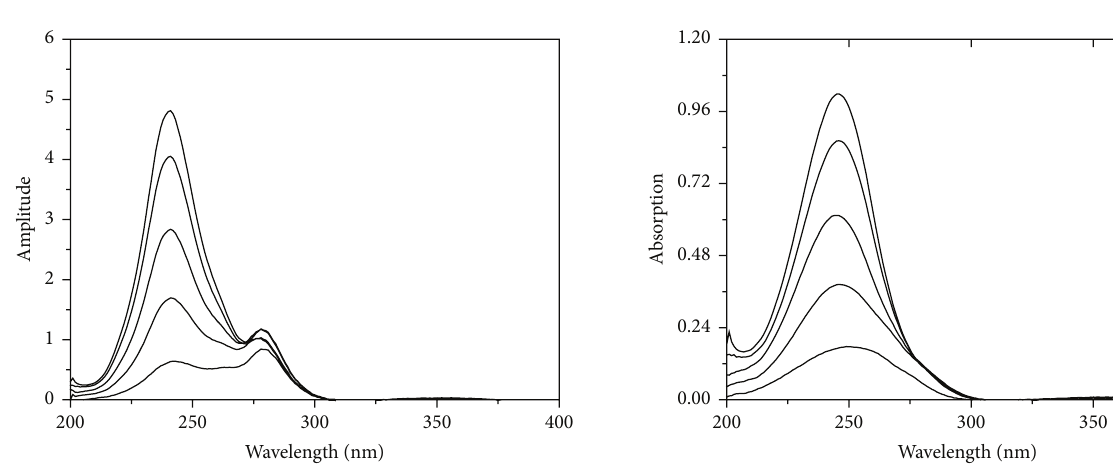
Figure 8: Ratio spectra of laboratory prepared mixtures of AA ( 𝑋 ) and RU ( 𝑌 ) using 8 𝜇 g/mL of RU ( 𝑌 󸀠 ) as a divisor and methanol as a blank after subtraction of the constant.